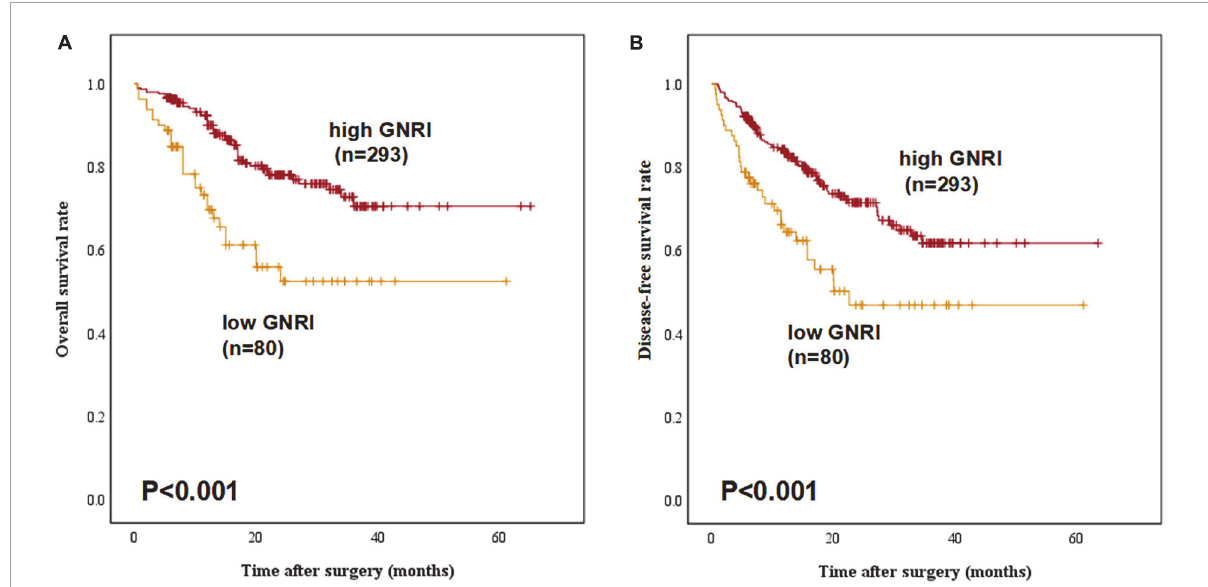
FIGURE1 Overall survival and disease-free survival curves stratified by geriatric nutritional index (GNRI) status: (A) overall survival and (B) disease-free survival of all study patients ( n = 373).